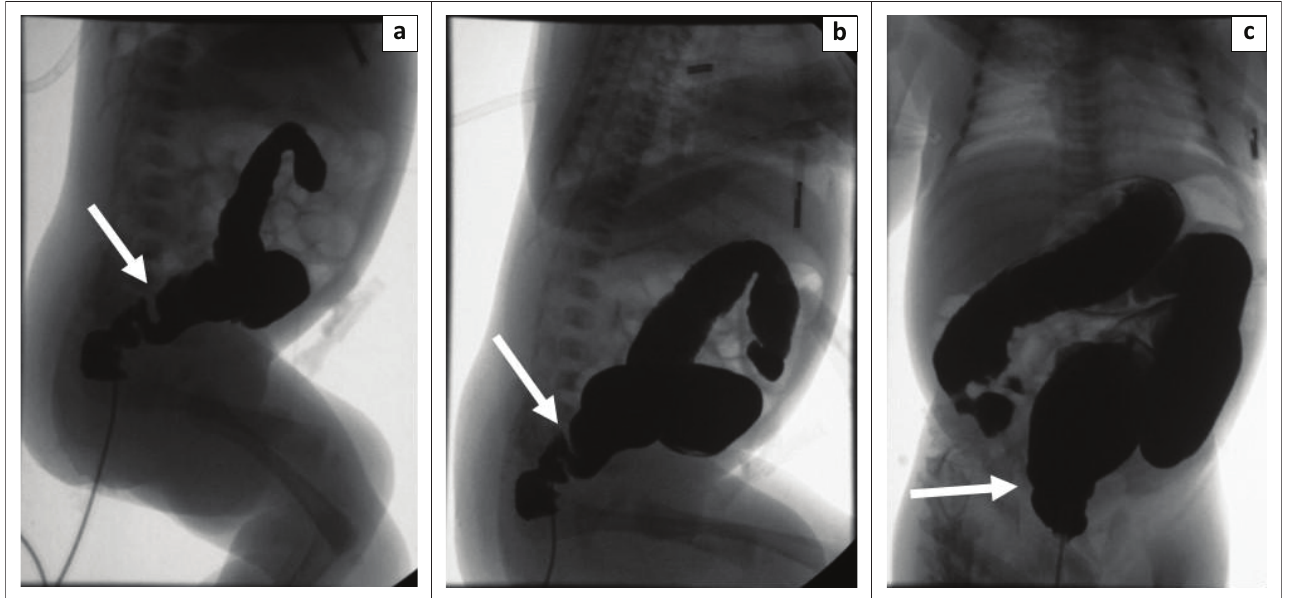
FIGURE 2: Lateral (a), oblique (b) and frontal (c) views demonstrating a zone of transition in the region of the recto-sigmoid junction (white arrows) in a patient with Hirschsprung disease. A reversed recto-sigmoid ratio is also seen.